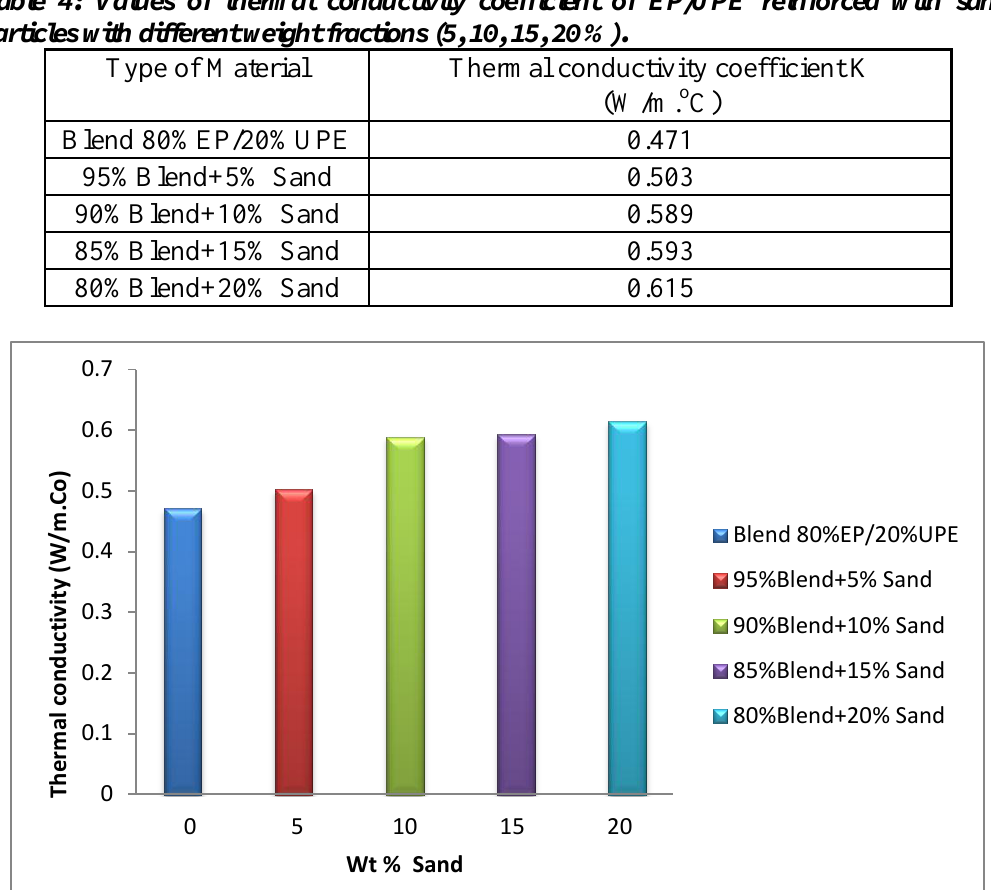
Fig. 3: Thermal conductivity at different weight fraction of the blend reinforced with sand